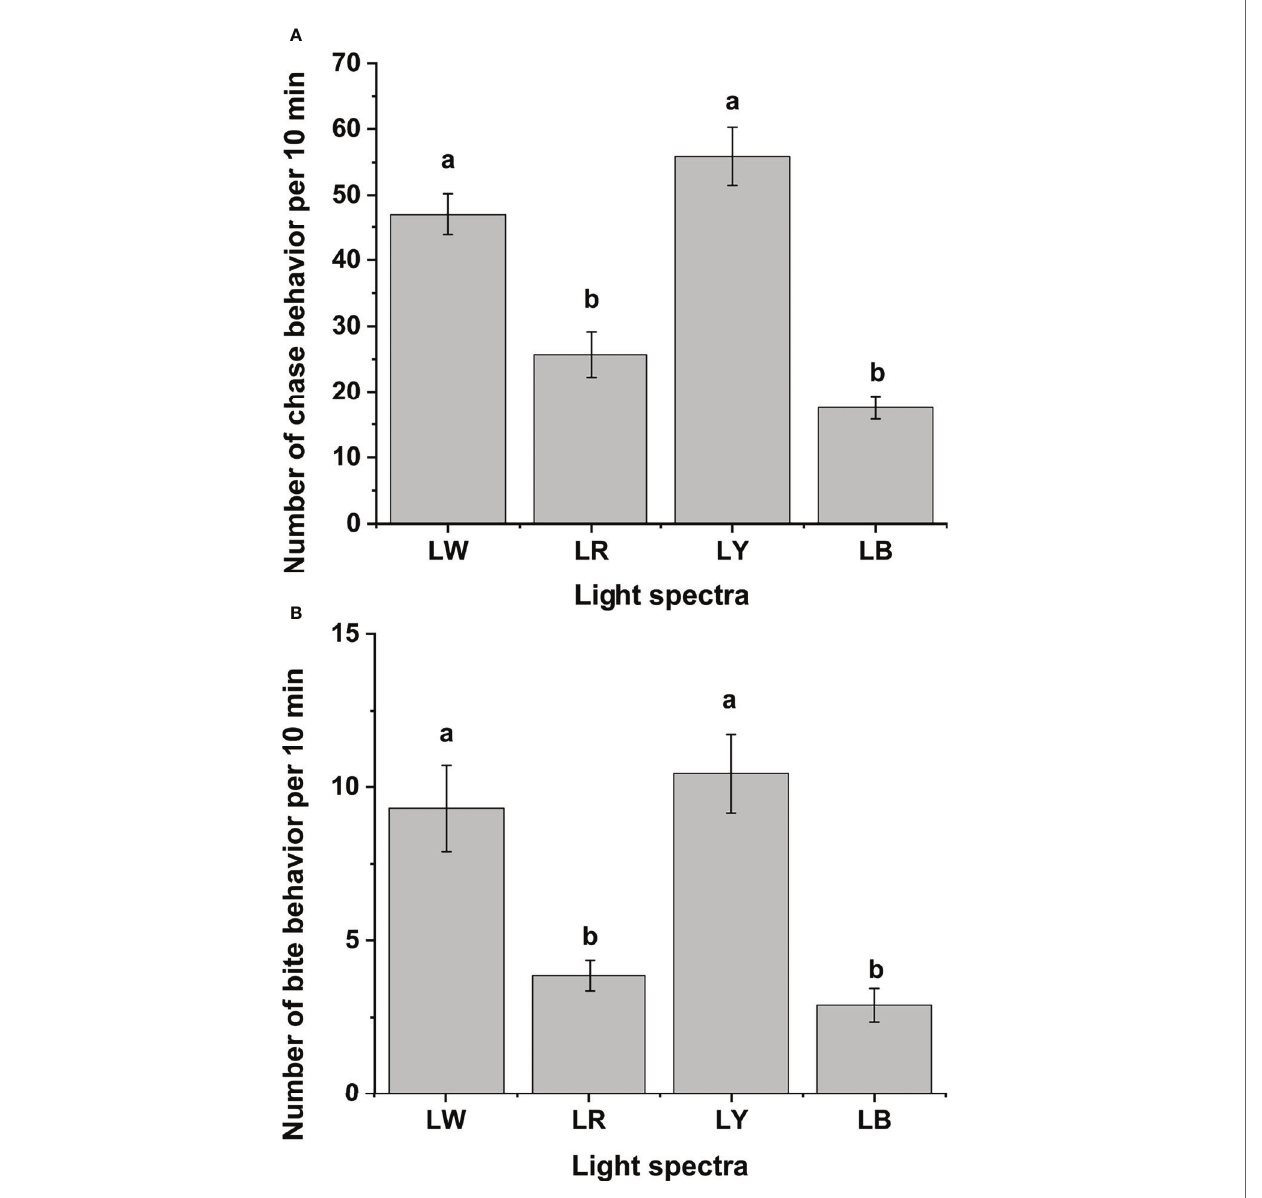
FIGURE 3 | The aggressive behaviors of GIFT tilapia juveniles under different light spectra. (A) The chase behavior number of GIFT tilapia juveniles under different light spectra per 10 min. (B) The bite behavior number of GIFT tilapia juveniles under different light spectra per 10 min. Different letters implies statistical differences (p <